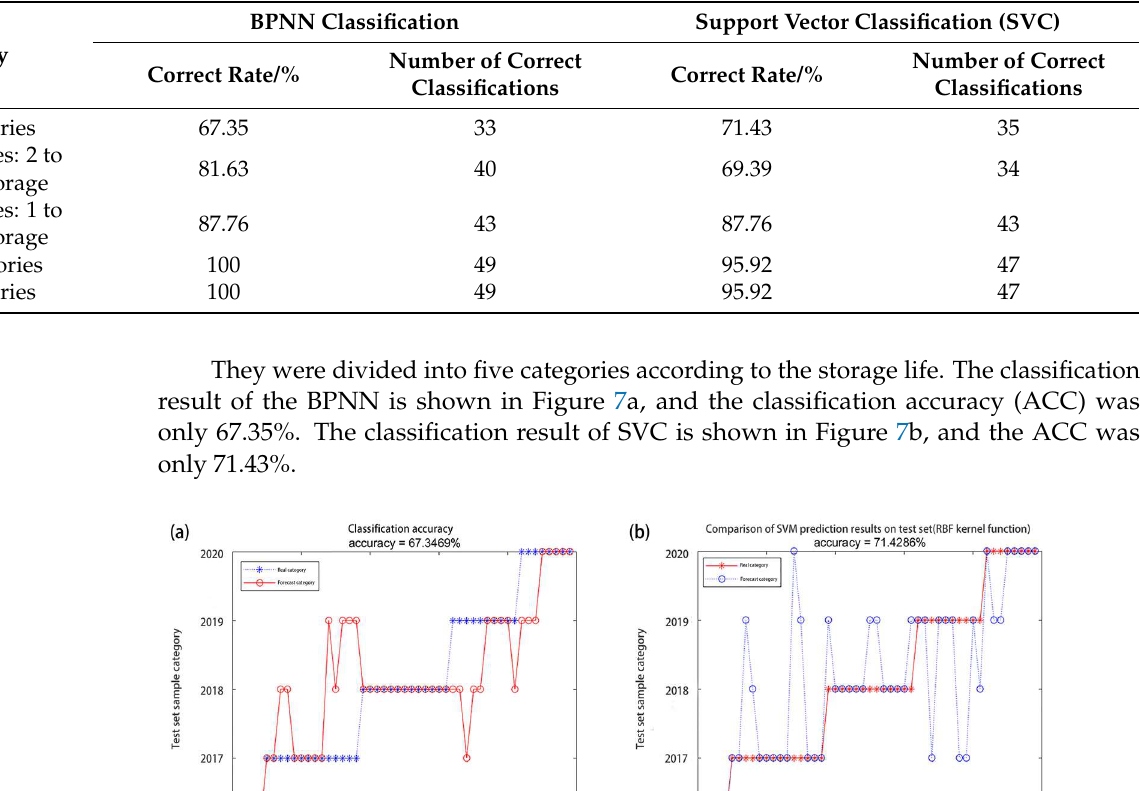
Table 4. Classifying results based on catalase activity.